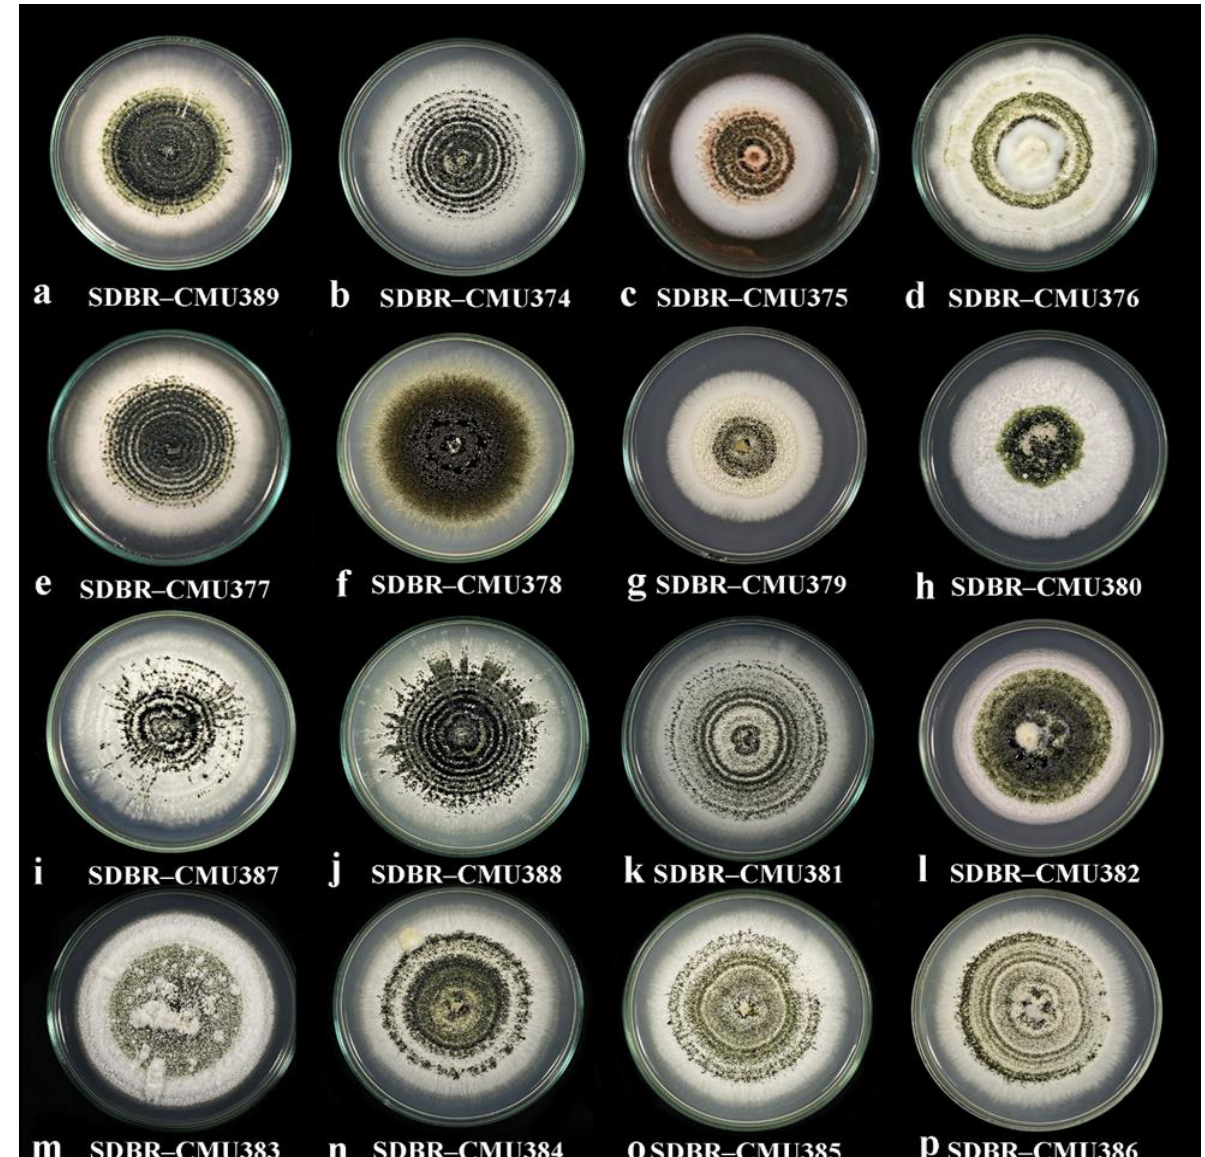
Figure 2. Colonies of Paramyrothecium species on PDA after 15 days at 25 – 30